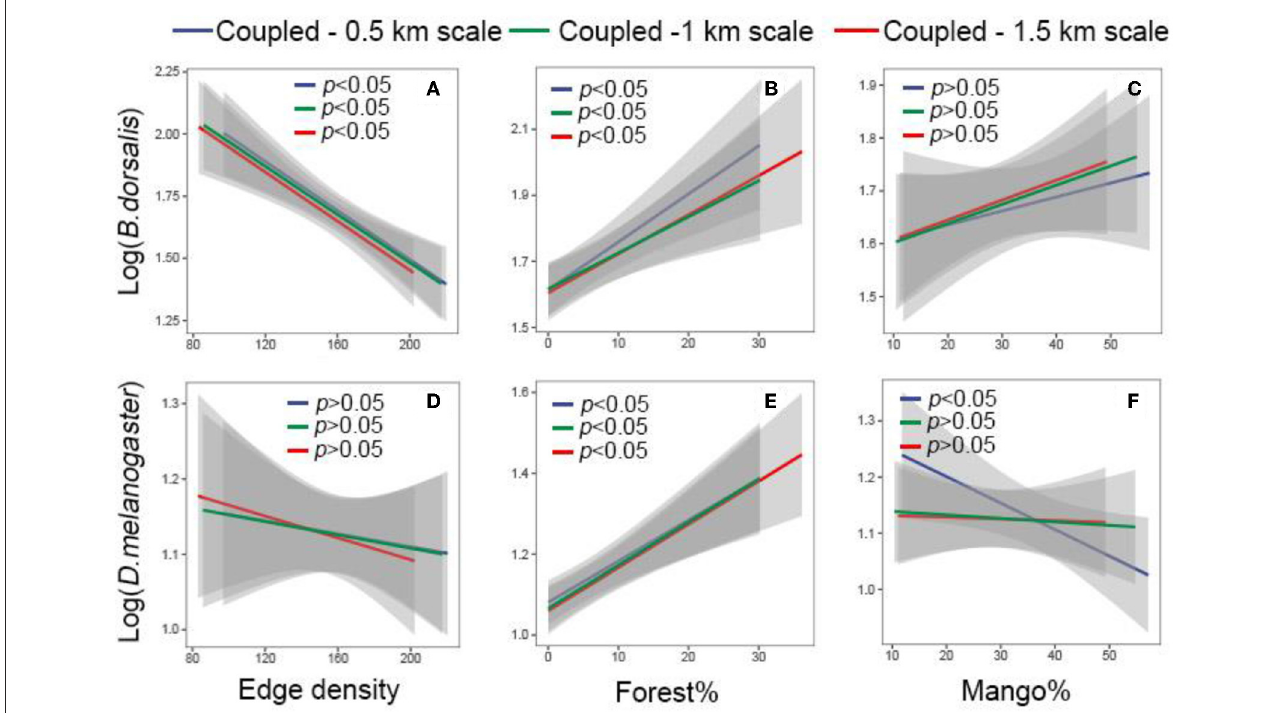
FIGURE3 Linear relationships between landscape heterogeneity and species at spatial distance scales (0.5, 1, and 1.5km). (A–C) Indicate log-transformed Bactrocera dorsalis abundance; (D–F) indicated log-transformed Drosophila melanogaster abundance. The blue, green, and red lines represent the spatial distance scales of 0.5, 1, and 1.5km, respectively. The coupled results are shown, and the decoupled results can be known from Supplementary Figure